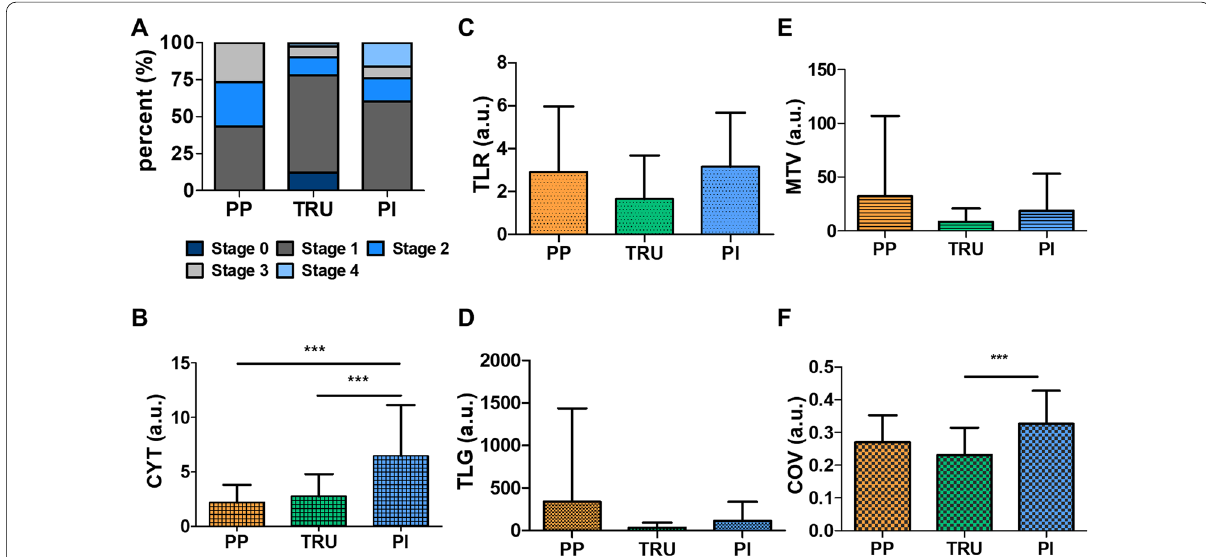
Fig. 2 Correlation between molecular subtypes, stages, CYT and 18 F‑FDG parameters: A the percent of each stage is represented in bar graphs according to each molecular subtype. B–F The scores of the CYT and 18 F‑FDG parameters are represented in bar graphs with the error bar by each molecular subtype. Three asterisks (***) mean P value < 0.001